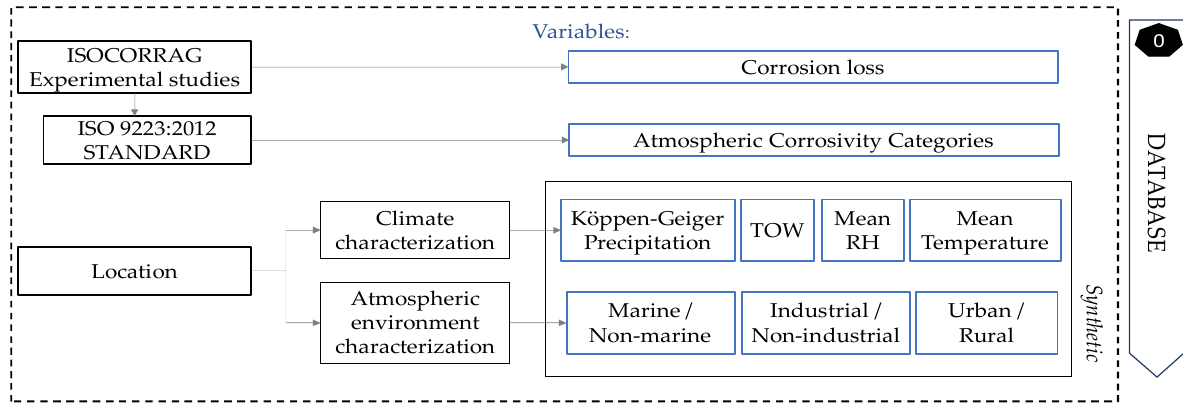
Figure 2. Flow chart for database creation and future locations characterisation.